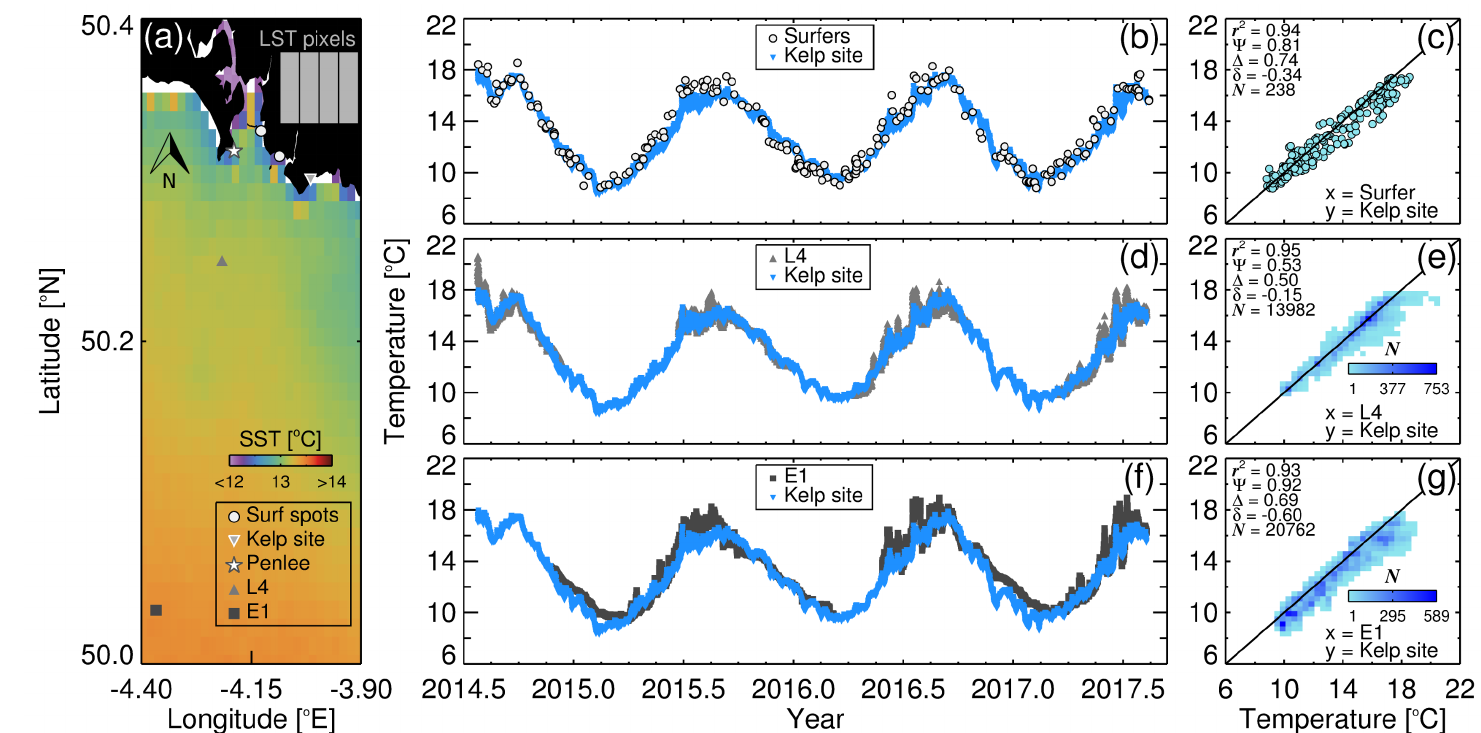
Figure 1. Comparison of in situ temperature data from the kelp site with three independent sea surface temperature (SST) datasets near Plymouth, UK. ( a ) locations of the kelp site, surfing data collected at the two beaches (Wembury and Bovisand), Station L4, Station E1, the Penlee Atmospheric Observatory, and the location of satellite pixels from a high temporal resolution time-series of Land Surface Temperature (LST) data acquired from the Copernicus Global Land Service. The background is a three-year mean composite of AVHRR satellite SST N data from July 2014 to June 2017. ( b ) time-series of SST acquired by the surfers at the two beaches overlain onto the kelp site temperature data; ( c ) scatter plots of match-ups (within ± 1h) between SST acquired by the surfer at the beaches and temperature data from the kelp site; ( d ) time-series of kelp site temperature data overlain onto the SST data from Station L4; ( e ) scatter plots of match-ups (within ± 1h) between SST at L4 and temperature data from the kelp site; ( f ) time-series of kelp site temperature data overlain onto the SST data from Station E1; ( g ) scatter plots of match-ups (within ± 1h) between SST at E1 and temperature data from the kelp site. r 2 is the coefficient of determination, Ψ the root mean square error, δ the bias, ∆ the centre-pattern (or unbiased) root mean square error, and N the number of